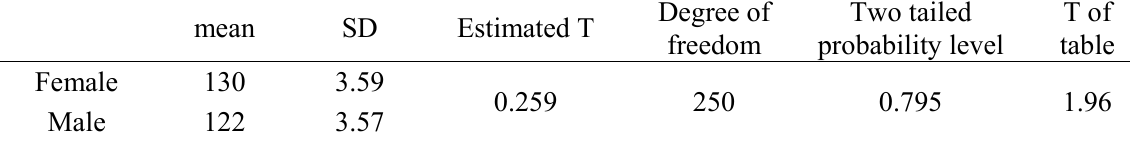
The results of attitudes towards luxury restaurant in terms of gender mean SD Estimated T